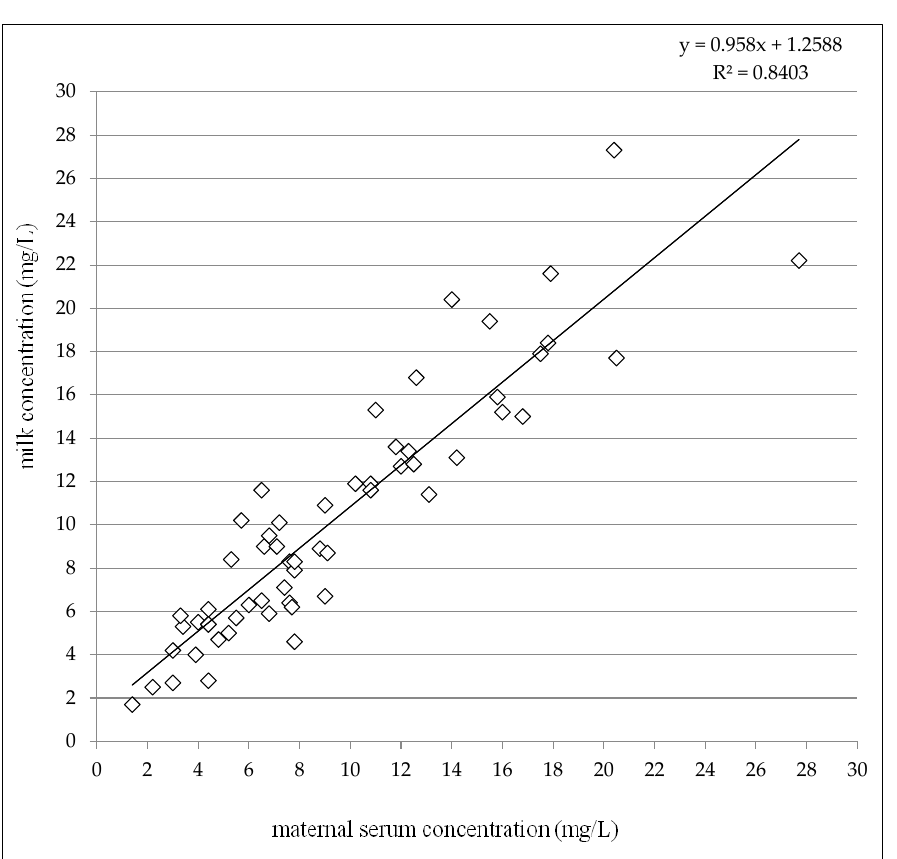
* p = 0.4688 (the Wilcoxon signed rank test)-maternal serum versus milk concentrations. ** p = 0.0043 (the Wilcoxon signed rank test)-maternal serum versus milk concentrations. Given the colostrum (2–4 days after delivery) and the later period (7–31 days after delivery) subgroups together, paired milk concentrations were slightly but significantly higher than maternal serum concentrations (median 9.0 mg/L versus 7.8 mg/L, p = 0.0043, the Wilcoxon signed rank test) and highly significant correlation between milk and maternal serum concentrations was observed ( p < 0.0001, the Spearman correlation coefficient = 0.9110), see Figure 4. The mean milk/maternal serum concentrations ratio was close to one (mean 1.13 ± 0.26) in comparison with the mean infant/maternal serum concentrations ratio which reached approximately a sixth of the value (mean 0.19 ± 0.13) similarly as the mean of infant serum/milk concentrations ratio (mean 0.17 ± 0.11), see